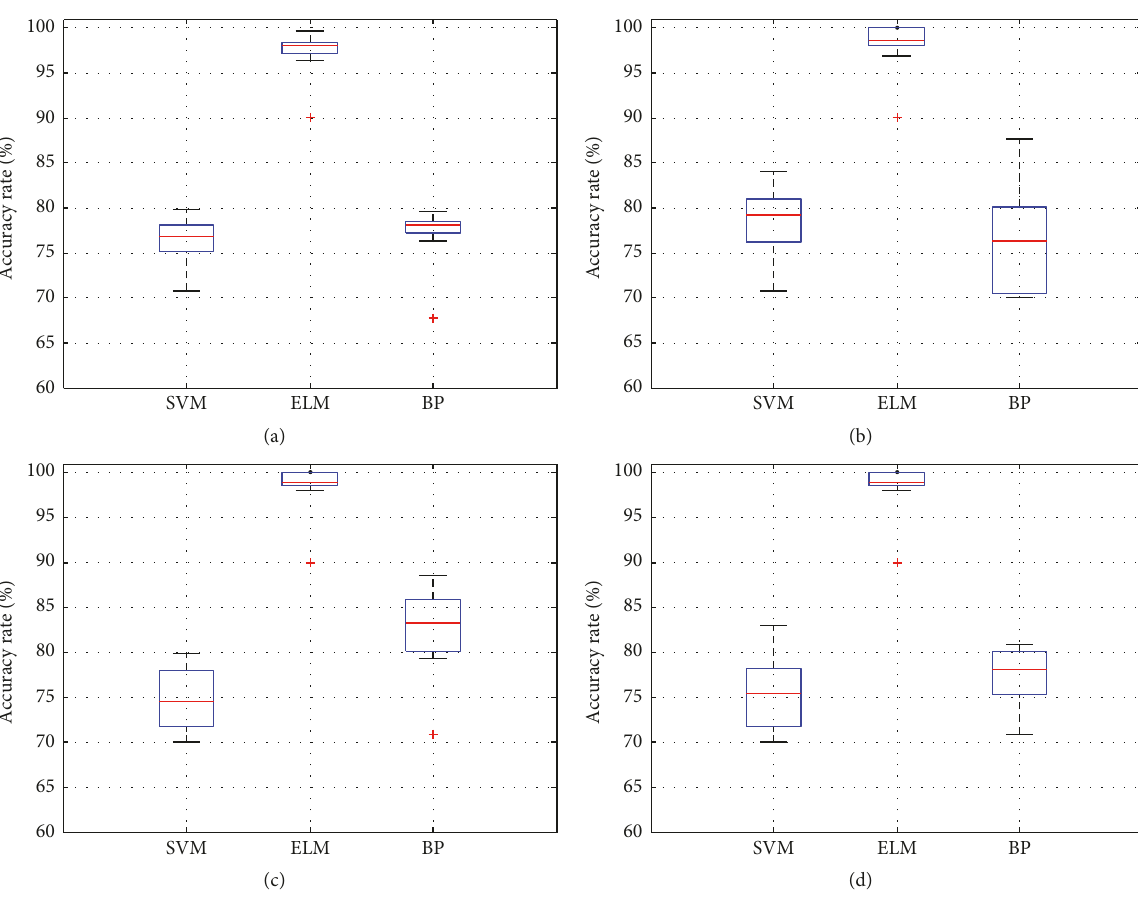
Figure 11: Test accuracy of classifiers: (a) normal, (b) rolling element fault, (c) outer race fault, and (d) inner race